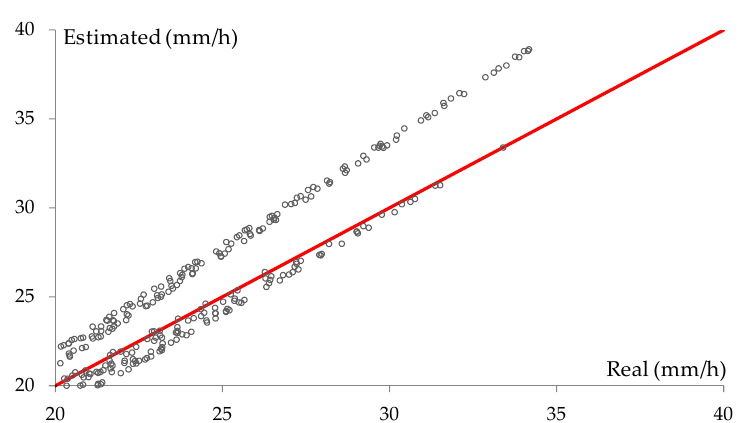
Figure 6. Validation of the methodology using data from Hurricane Patricia, 23 (22:00) to 24 (06:30) October 2015, in the MGS Atoyac, Guerrero. (R 2 = 0.9605).